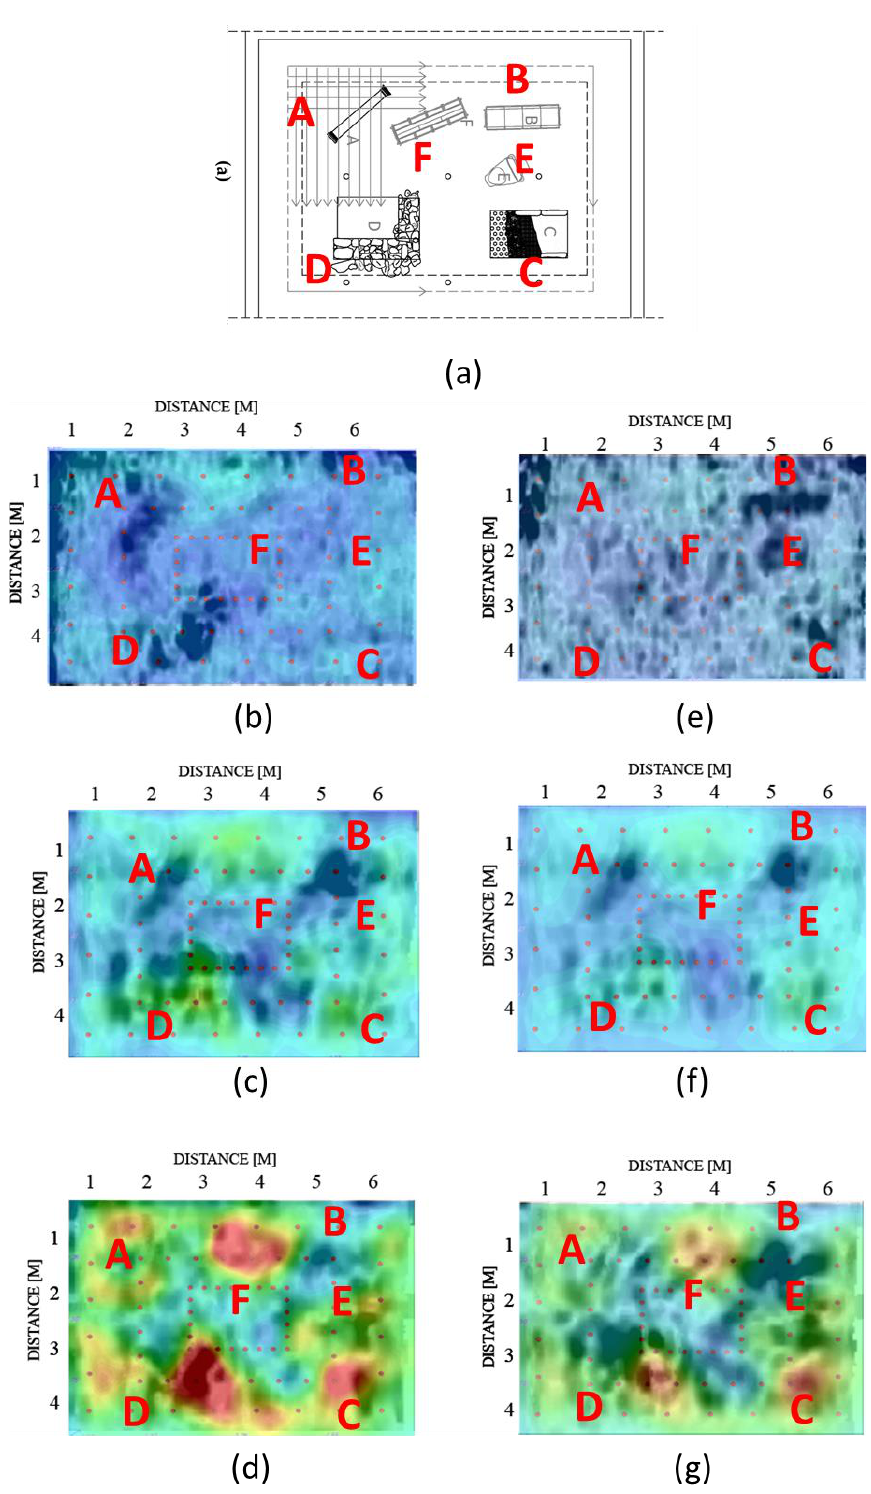
Figure 17. Model co-rendered GPR and ERT loop–loop depth slices at 0.45 m ( left column ) and 0.70 m ( right column ) in WL1 ( b – e ), WL2 ( c – f ), and WL3 ( d – g ) with the site plan ( a ).